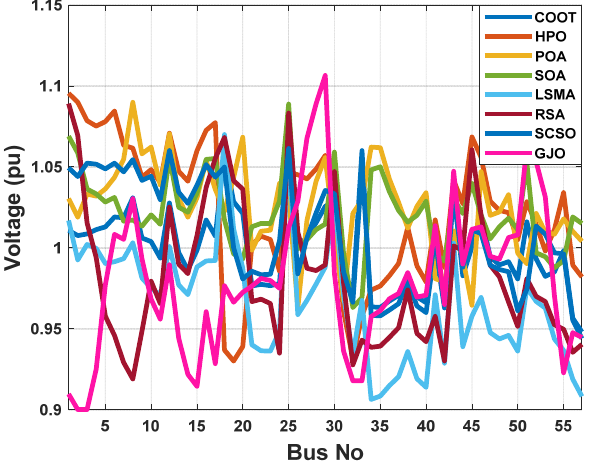
Figure 27. The voltage profile of the POA and other compared algorithms for case 4 in a standard IEEE 57-bus test system.